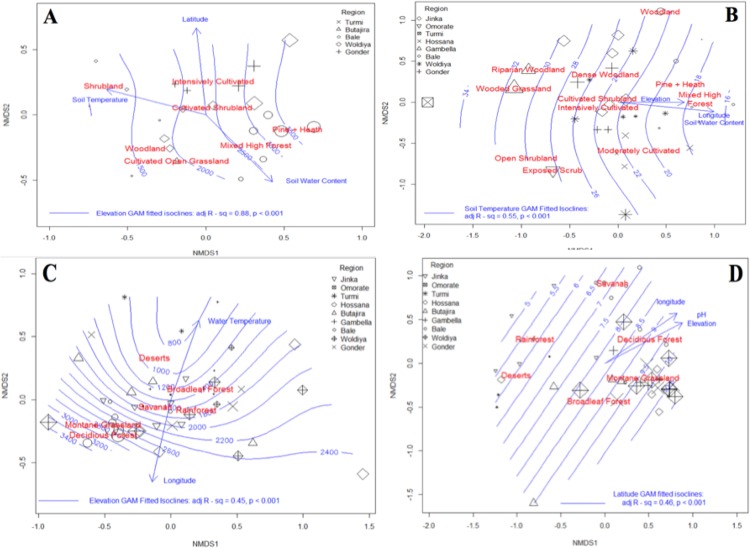
The effect of environmental variables on the presence of slow growing mycobacteria.NMDS ordination of slow growing mycobacterium water community’s highlighting the effect of each significant environmental variables upon the separation of the data points. GAM fitted isoclines represent predicted values for latitude and the size of each point represents the true value for this variable. A = mycobacteria communities in soil, B = slow growing mycobacteria in soil, C = mycobacteria in water, D = slow growing mycobacteria in water.